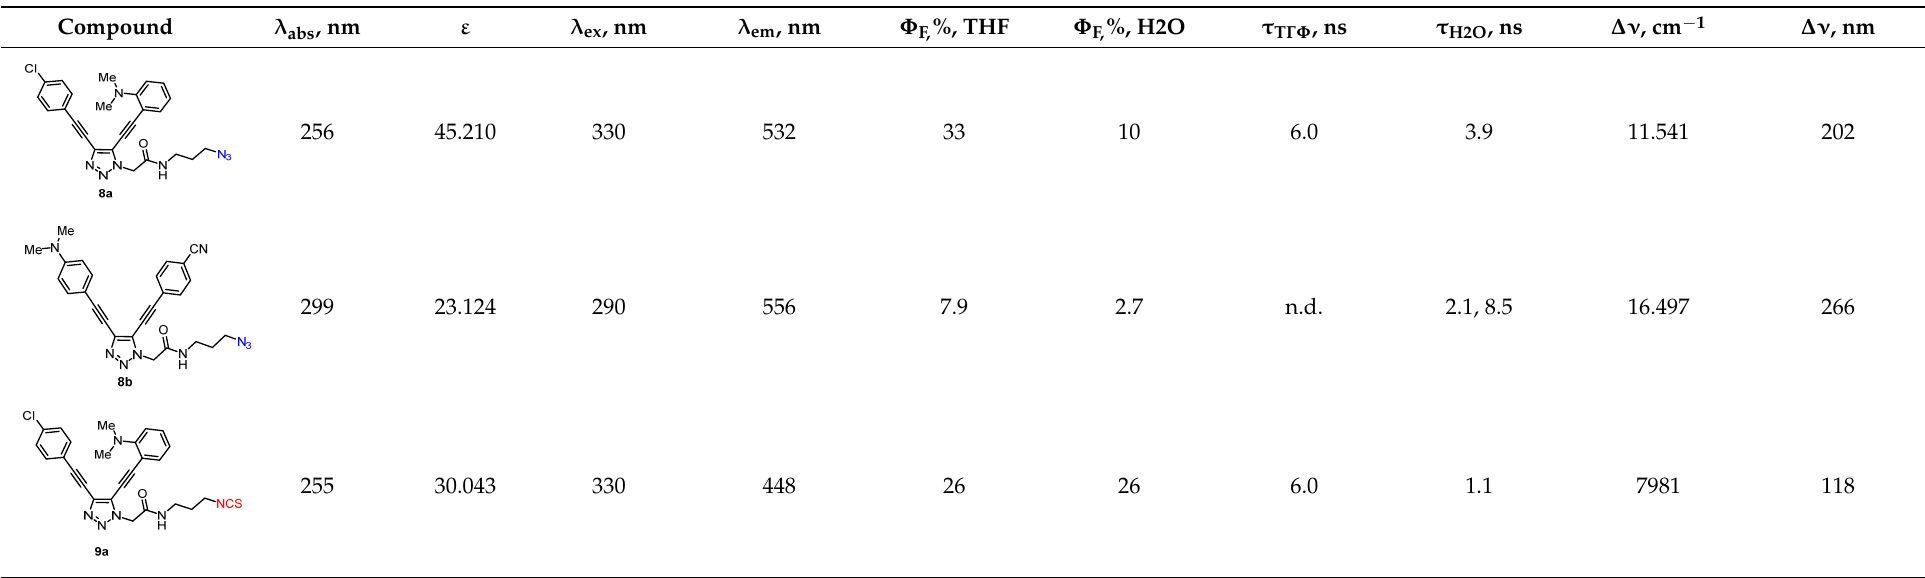
Table 2. Photophysical data of 8a , b, and 9a.